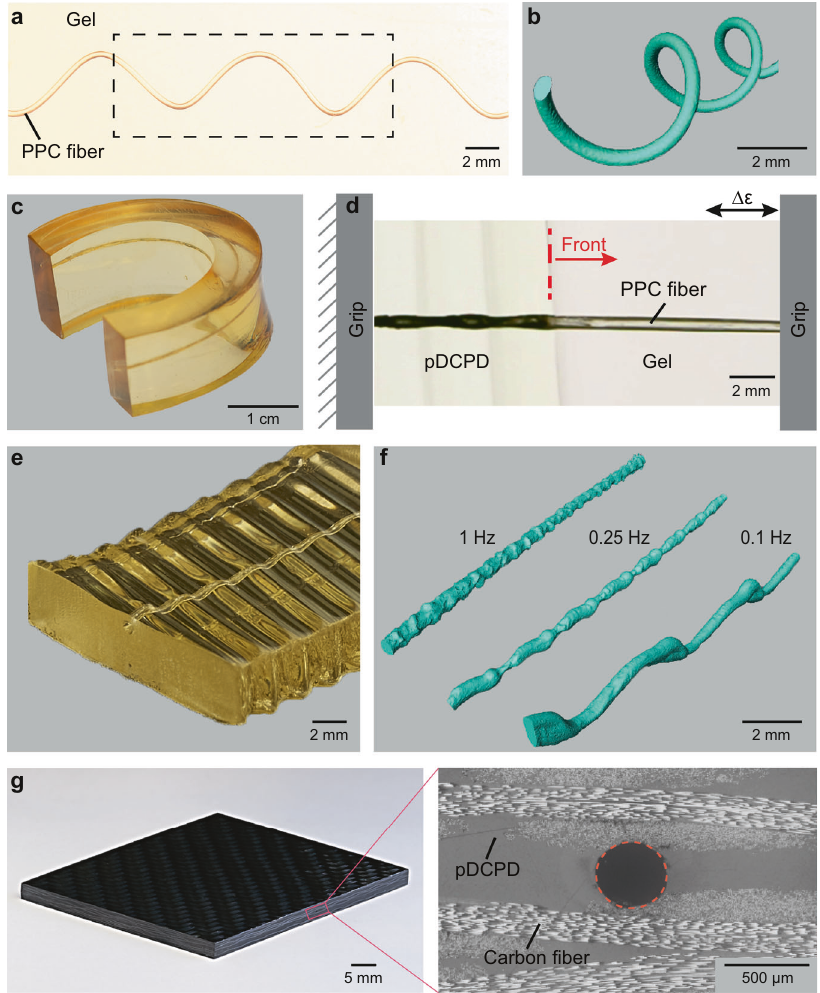
Fig. 3 Advanced manufacturing of microvascular structures. a – f On-demand modulation of the vascular architecture in free-standing elastomeric DCPD gels ( α 0 = 0.25). a Optical image of a helical sacri fi cial template (diameter = 384 ± 10 μ m) embedded in a DCPD gel prior to FP. b μ CT reconstruction of the resulting microchannel (diameter = 404 ± 12 μ m) fi lled with a radiocontrast fl uid for the sample region encompassed by the dashed box in a . c Microchannel inside a horseshoe-shaped pDCPD structure traces the curvature of the matrix. d – f Concurrent polymerization and vascularization under oscillatory loading create sinusoidal microchannels. Representative optical images of FP under oscillatory strain (frequency = 0.25 Hz, amplitude = 4 mm) and resulting vascularized structure are shown in d and e , respectively. f µ CT reconstructions of microchannels fi lled with a radiocontrast fl uid show an increase in out-of-plane deformation for decreasing oscillation frequency. g Optical image and micrograph of the cross section of a void-free composite with a circular microchannel (dashed orange line) fabricated in 30 s under ambient